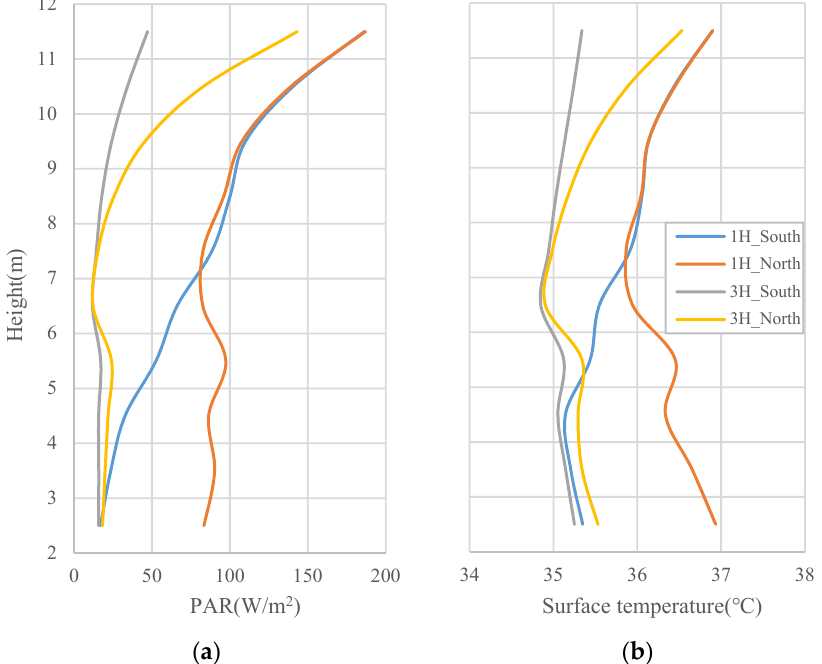
Figure 6. Vertical profile of photosynthetically active radiation (PAR) ( a ) and leaf surface temperature, ( b ) of the 213th day according to the tree location/building height (1H,3H). (Leaf area density (LAD) distribution: C.D).